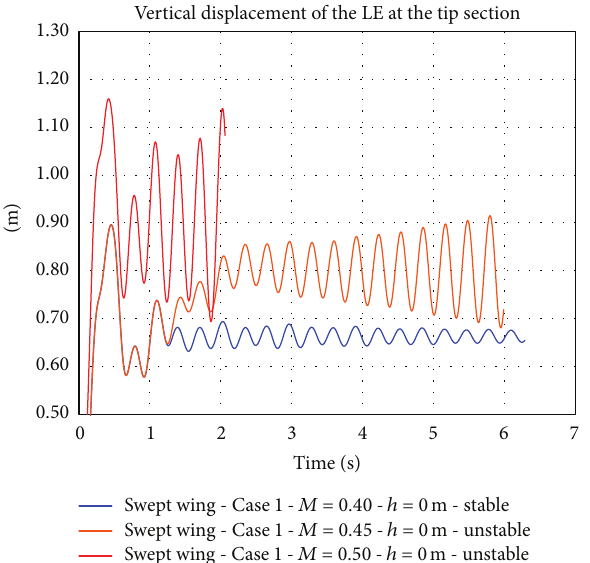
Figure 7: Results of the FSI analyses of the swept wing (Case 1 , sea